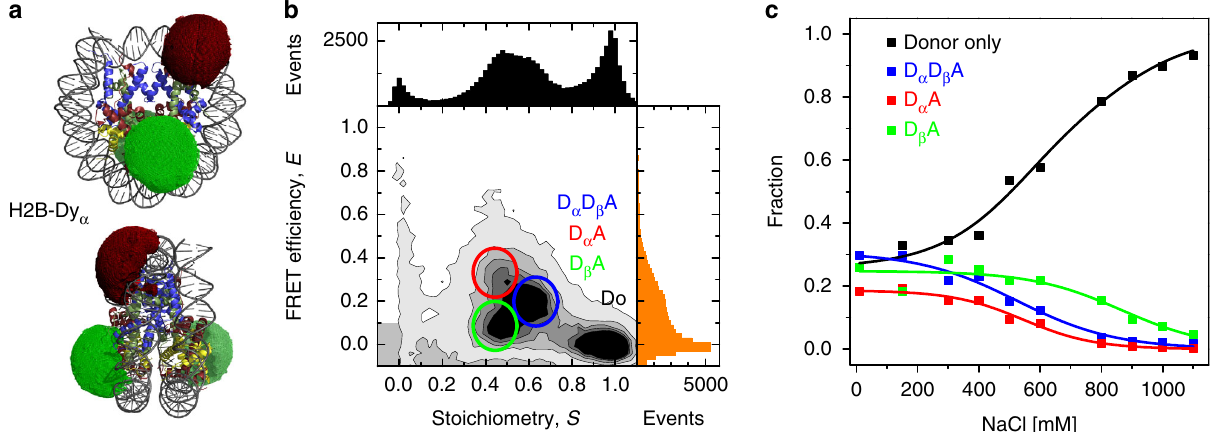
Fig. 1 Overview on FRET dye positions in the nucleosome constructs. The names of the constructs assign the position and side of the fl uorescent labels: fi rst the donor (green circle) and second the acceptor (red circle). In the cartoon representations, the H2A-H2B dimers are shown in orange, the (H3-H4) tetramer in turquoise, DNA in gray. To account for the asymmetry, we denote by α the left side of the DNA sequence (forward (-) strand) with base pairs counted in negative numbers from the fragment center (position 0). The other side is called β , with base pairs counted in positive numbers ( ( + ) strand). The dye labeling positions on the DNA are given as relative base shifts to the middle of the sequence: Dy acceptor close to dyad axis at positions − 15 and + 15, E donor labeling position at the end of the DNA strand at positions − 85 and + 85, I internal labeling position on the DNA + 41 (donor) and − 53 (acceptor), H2B donor at position 112 of H2B using the H2B-T112C mutant, mut the H2A-R81A mutation is represented by a black triangle on the